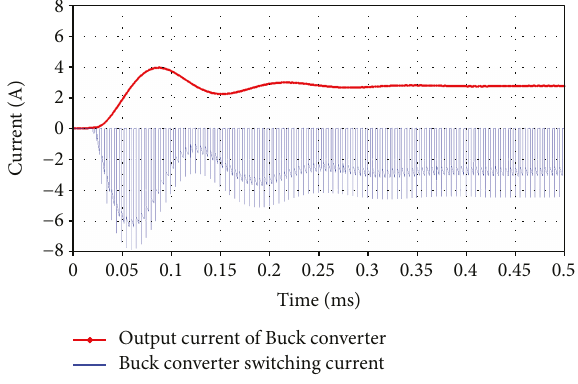
Figure 15: Input and output current waveforms for 50 V input.